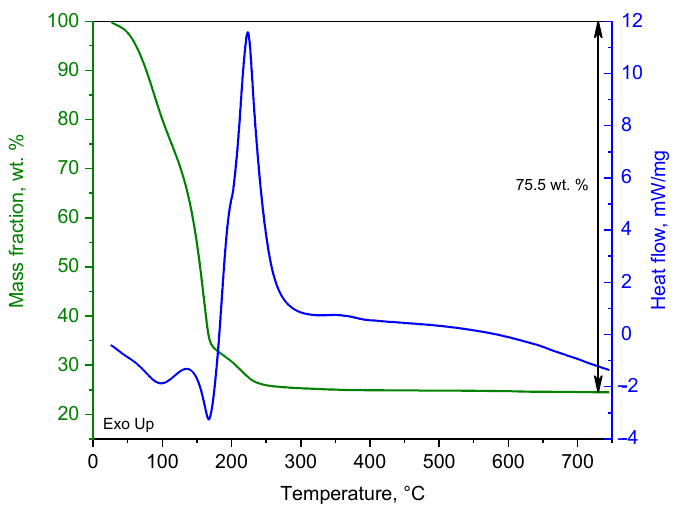
Figure 9. Results of the TG-DSC thermal analysis of the as-prepared ink. The green curve is the mass of the sample, and the blue curve is the heat flow per unit mass of the sample. The sample was heated at a rate of 10 °C/min in air supplied at a flow rate of 250 mL/min.